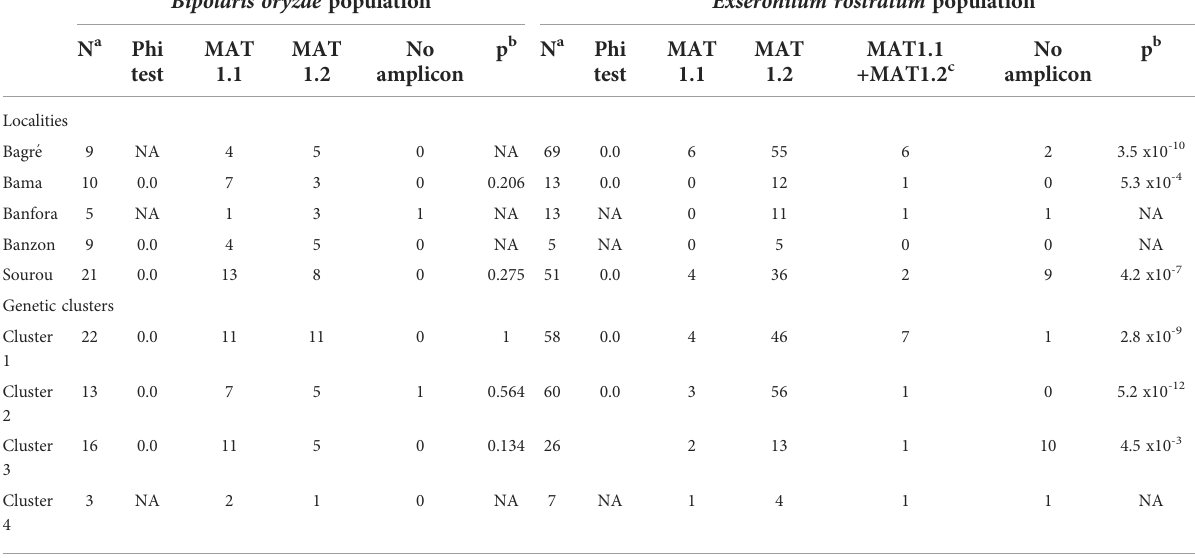
TABLE 7 Distribution of mating types in B. oryzae and E. rostratum populations in fi ve rice growing areas of Burkina Faso. Bipolaris oryzae